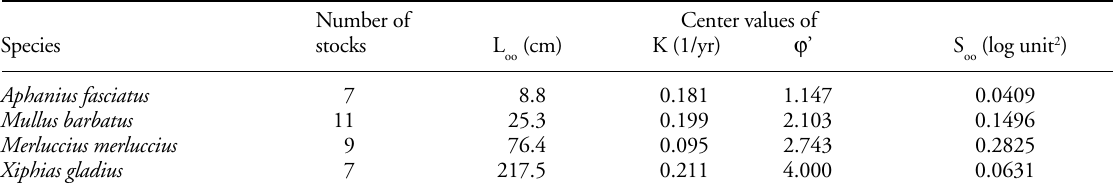
Table 3. Asymptotic surfaces S K values for each stock per species are from Stergiou et al. (1997).